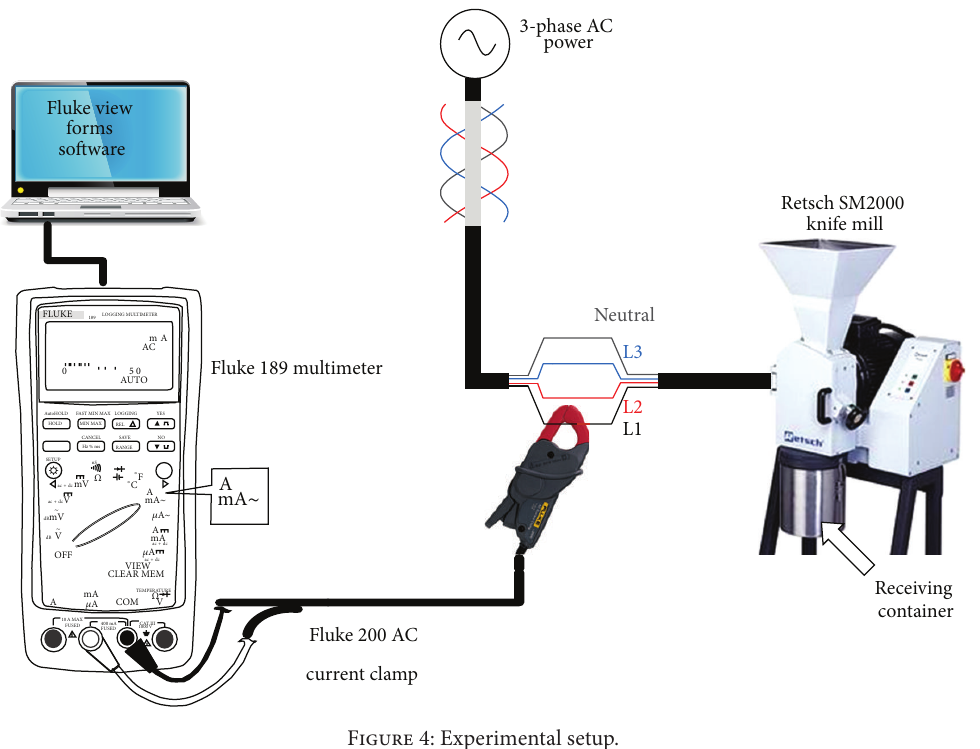
Figure 4: Experimental setup.